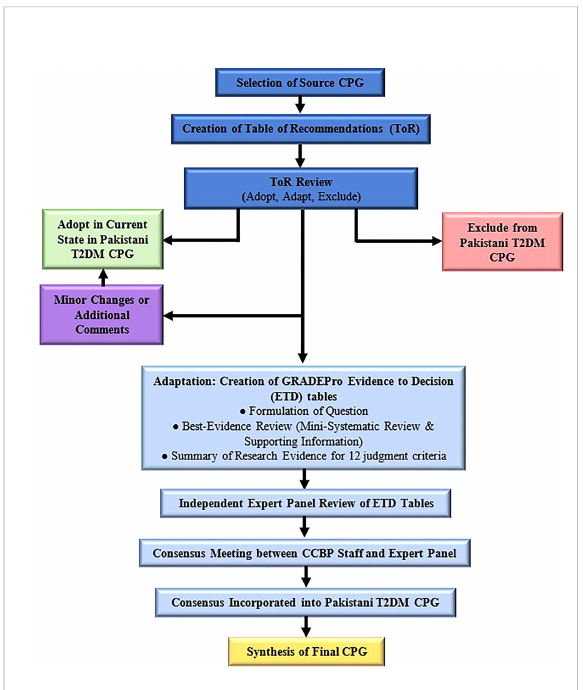
FIGURE 1 GRADE-ADOLOPMENT process for T2DM CPG for